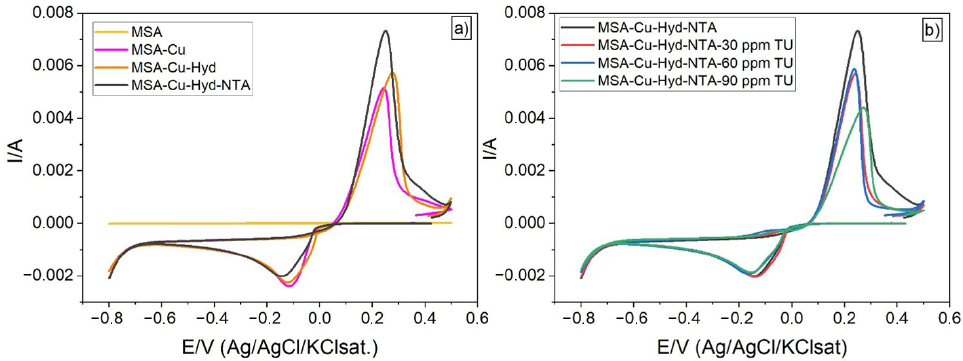
Figure 1. CVs of Cu(II)MSA 0.17 M in MSA 4.6 M aqueous solution, 50 mV ∙ s –1 the scan rate: ( a ) addition of Hyd 0.1 M and NTA 0.1 M to the copper solution; ( b ) addition of 30/60/90 ppm of TU to the solution.